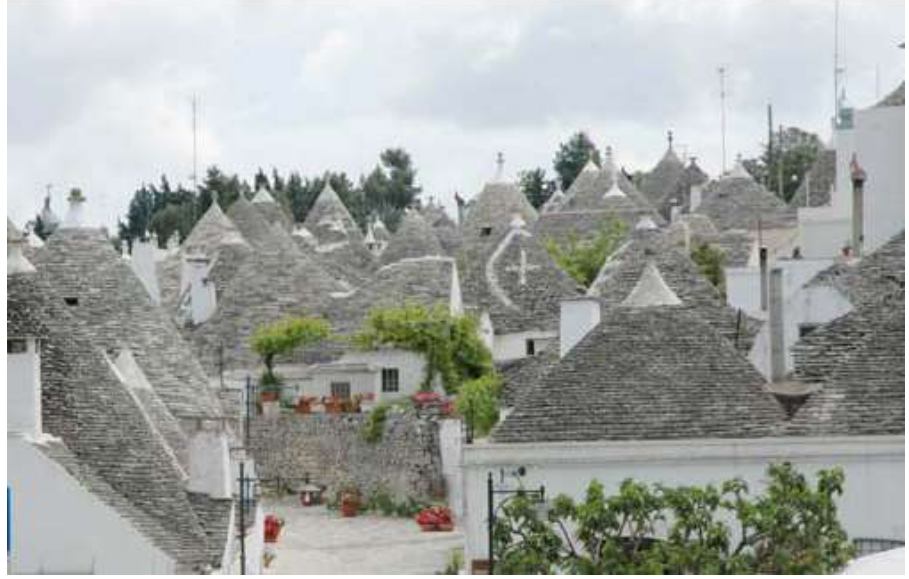
Figure 1. Trulli in Alberobello (Puglia, Italy).